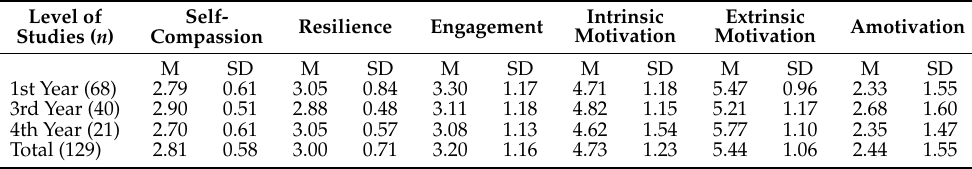
Table 4. One-way MANOVA: difference in the mean self-compassion, resilience, engagement and motivation between different levels of